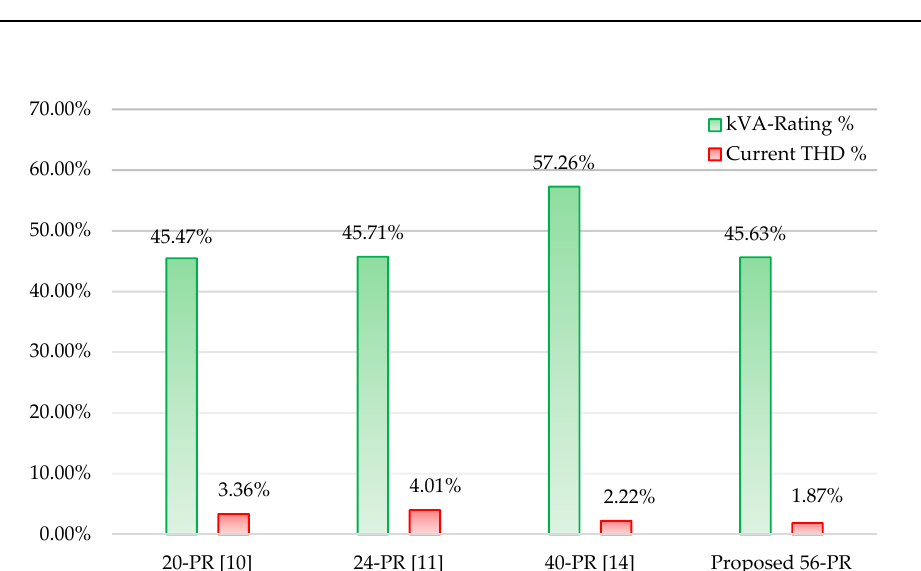
Figure 16. Comparison of the exiting multi-pulse rectifiers with the proposed 56-PR in terms of THD and kVA-rating (as percentages).